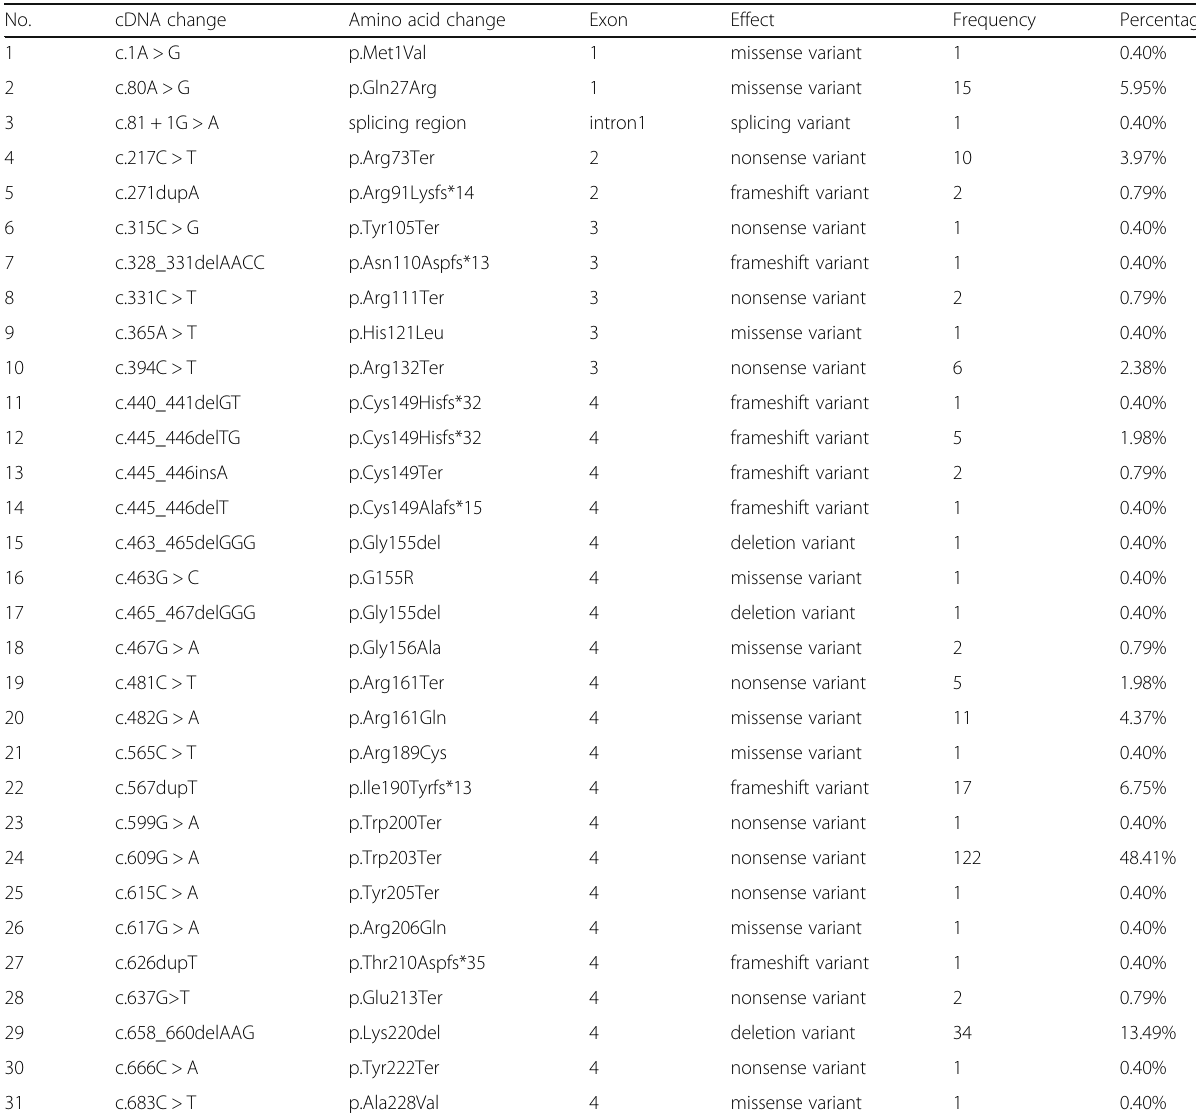
Table 1 MMACHC gene variants for 126